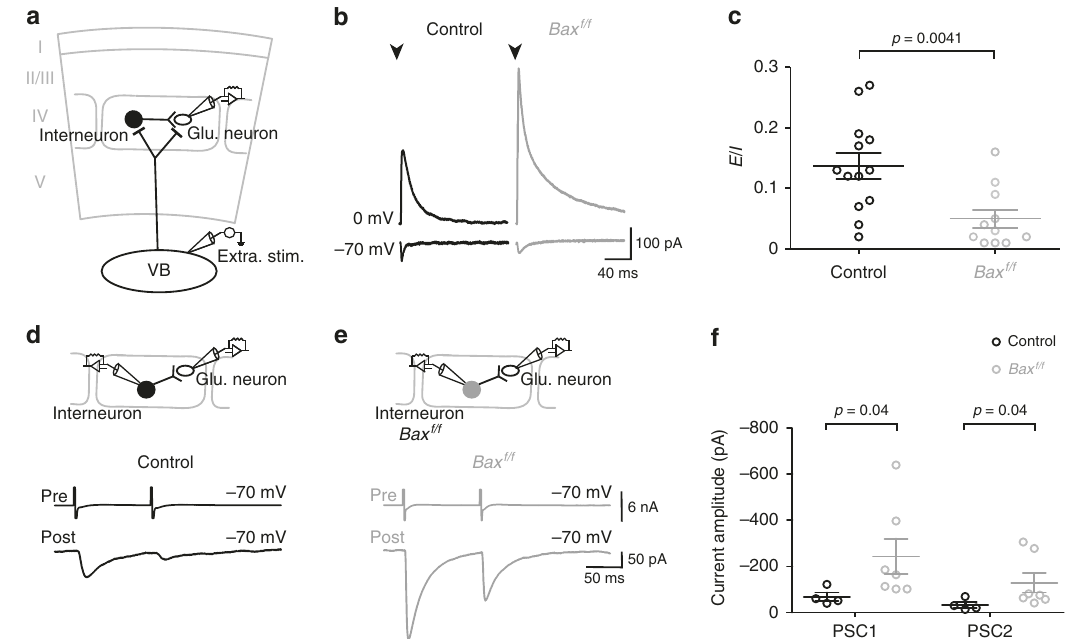
Fig. 6 An exceeding number of interneurons increases inhibition in neuronal networks. a Diagram representing the experimental procedure where a layer IV glutamatergic neuron recorded during the extracellular stimulation of the ventro-basal nucleus (VB) of the thalamus. In this circuit, the recorded neuron is synaptically connected by FSI which also receive thalamic input that triggers a strong disynaptic feedforward inhibition. b Excitatory (inward) and inhibitory (outward) PSCs evoked by thalamic stimulation in layer IV glutamatergic neurons of control (black) and Bax f/f mice (dark gray) recorded at − 70 and 0 mV, respectively, in acute thalamocortical slices during the third postnatal week. Stimulation artifacts were blanked for visibility. The stimulation time is indicated (arrowheads). c Dot plots of excitation/inhibition ( E / I ) ratio obtained for glutamatergic neurons in control (black, n = 13) and Bax f/f (dark gray, n = 10) mice by dividing excitatory PSCs by inhibitory PSCs (Mann – Whitney U test; signi fi cant p -value is indicated). d , e Paired recordings between a presynaptic FSI and a layer IV glutamatergic neuron in control (black, d ) and Bax f/f (dark gray, e ) mice. Note that action currents evoked in FSI elicited larger PSCs in glutatamergic neurons of Bax f/f mice. f Dot plots of PSCs evoked by the fi rst (PSC1) and second (PSC2) action current in the FSI (Mann – Whitney U test; signi fi cant p -value are indicated). The paired-pulse ratio (PPR = PSC1/PSC2) was not different between control (black, n = 4 out of 8 pairs connected) and Bax f/f (dark gray, n = 7 out of 7 pairs connected) mice, indicating that there were no changes in the release probability of presynaptic FSI (PPR: 0.45 ± 0.05 and 0.52 ± 0.07, respectively; p = 0.412, Mann – Whitney U test). Data are presented as mean ±